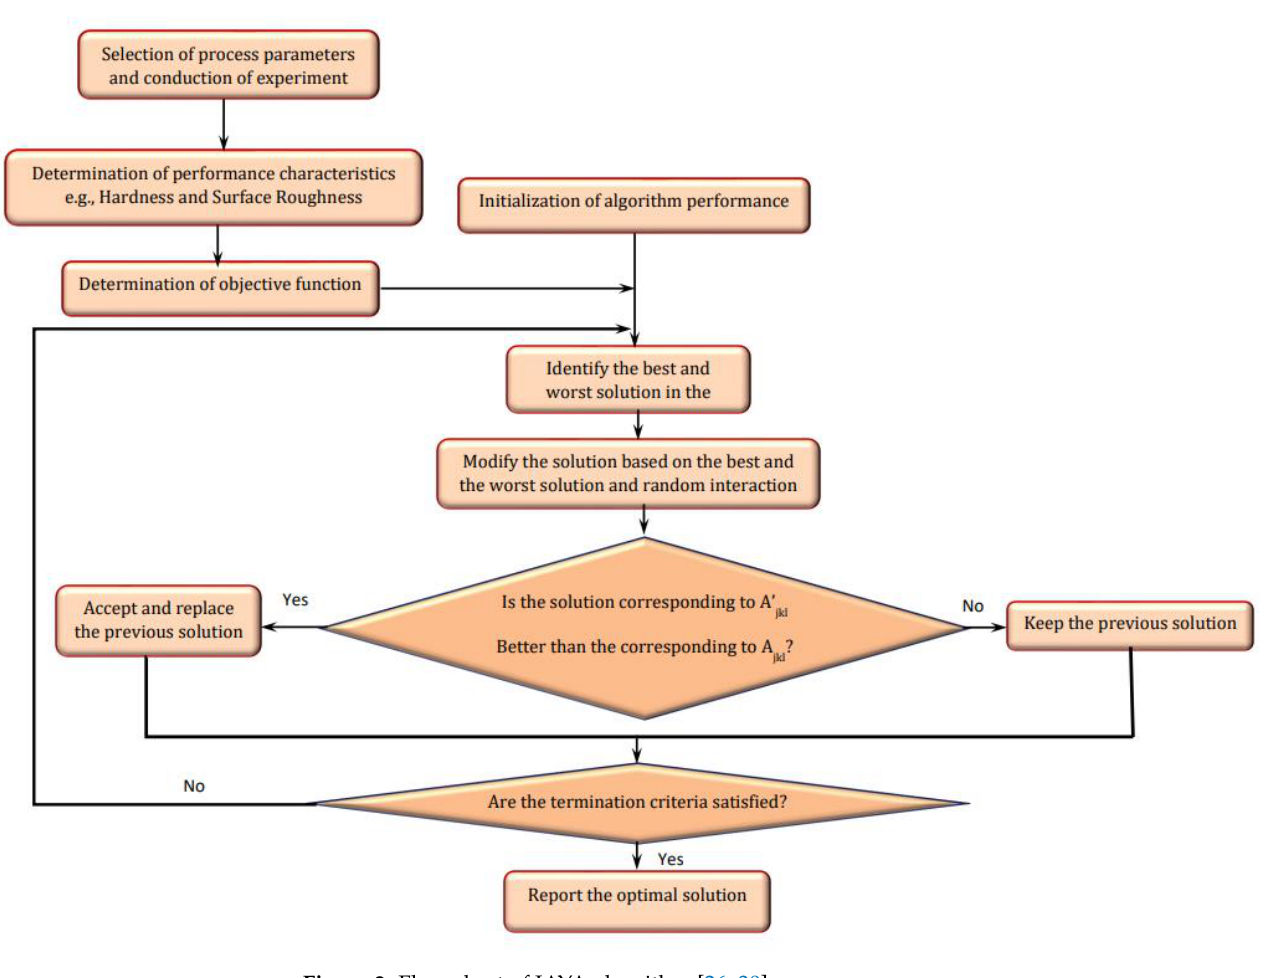
Figure 2. Flow chart of JAYA algorithm [26-30].